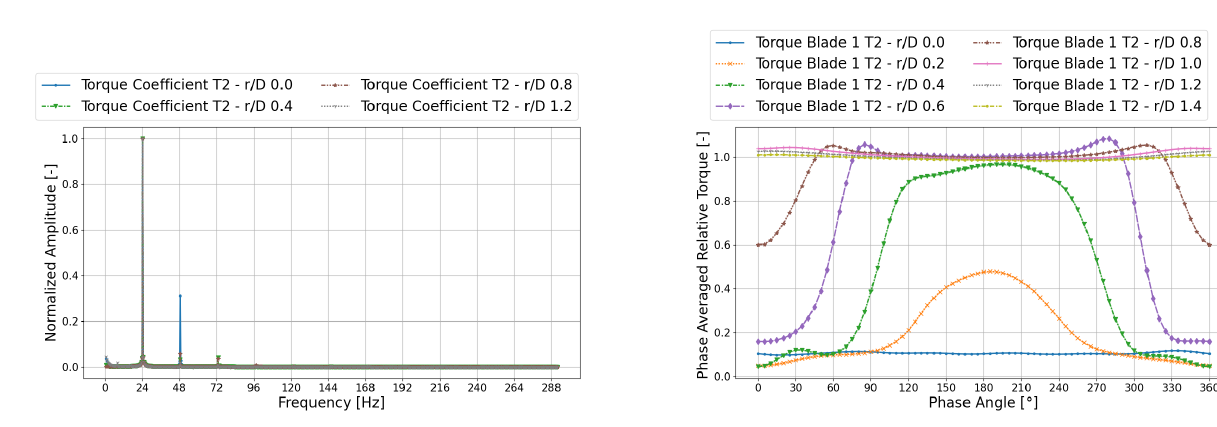
Fig. 12. Phase averaged torque of blade 1 of second turbine. Torque relative to average torque of case r/D = 1 . 2 . A phase angle Φ = 0 ◦ denotes the blade being in top vertical